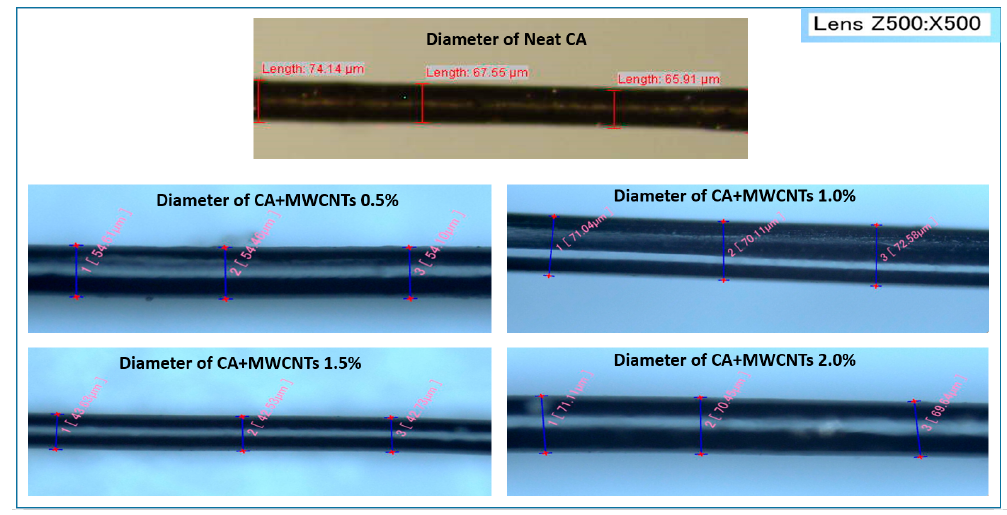
Figure 2. Optical microscopic images of fiber diameter. Table 1. Tensile test results.